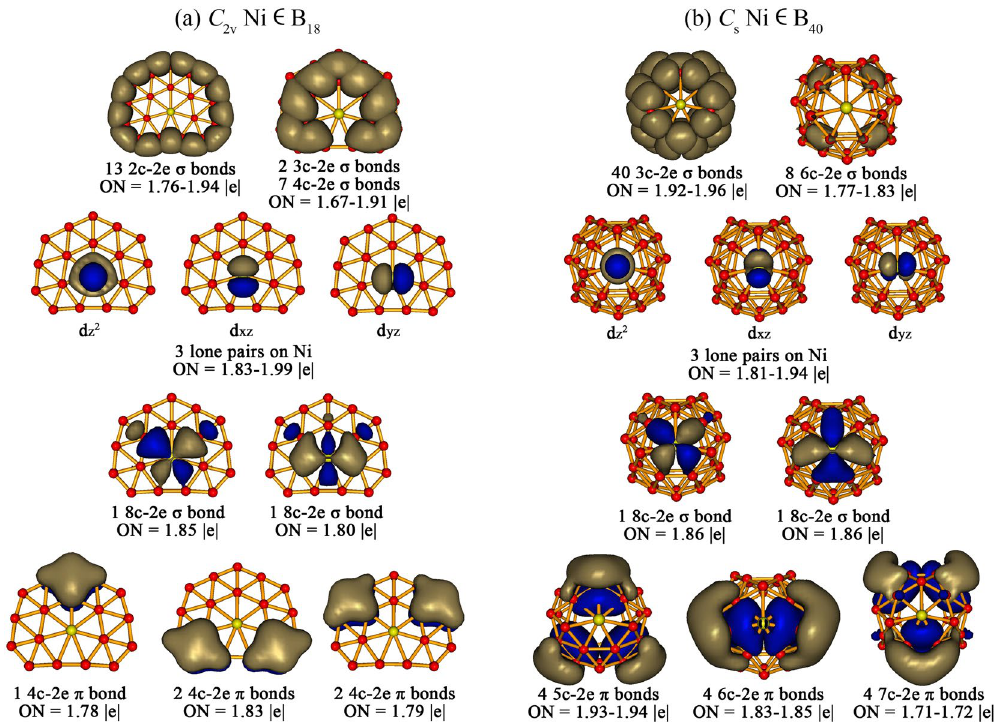
Figure 2. Comparison of the AdNDP bonding patterns of ( a ) C 2v Ni ∈ B 18 ( 1 ) and ( b ) C s Ni ∈ B 40 ( 2 ).